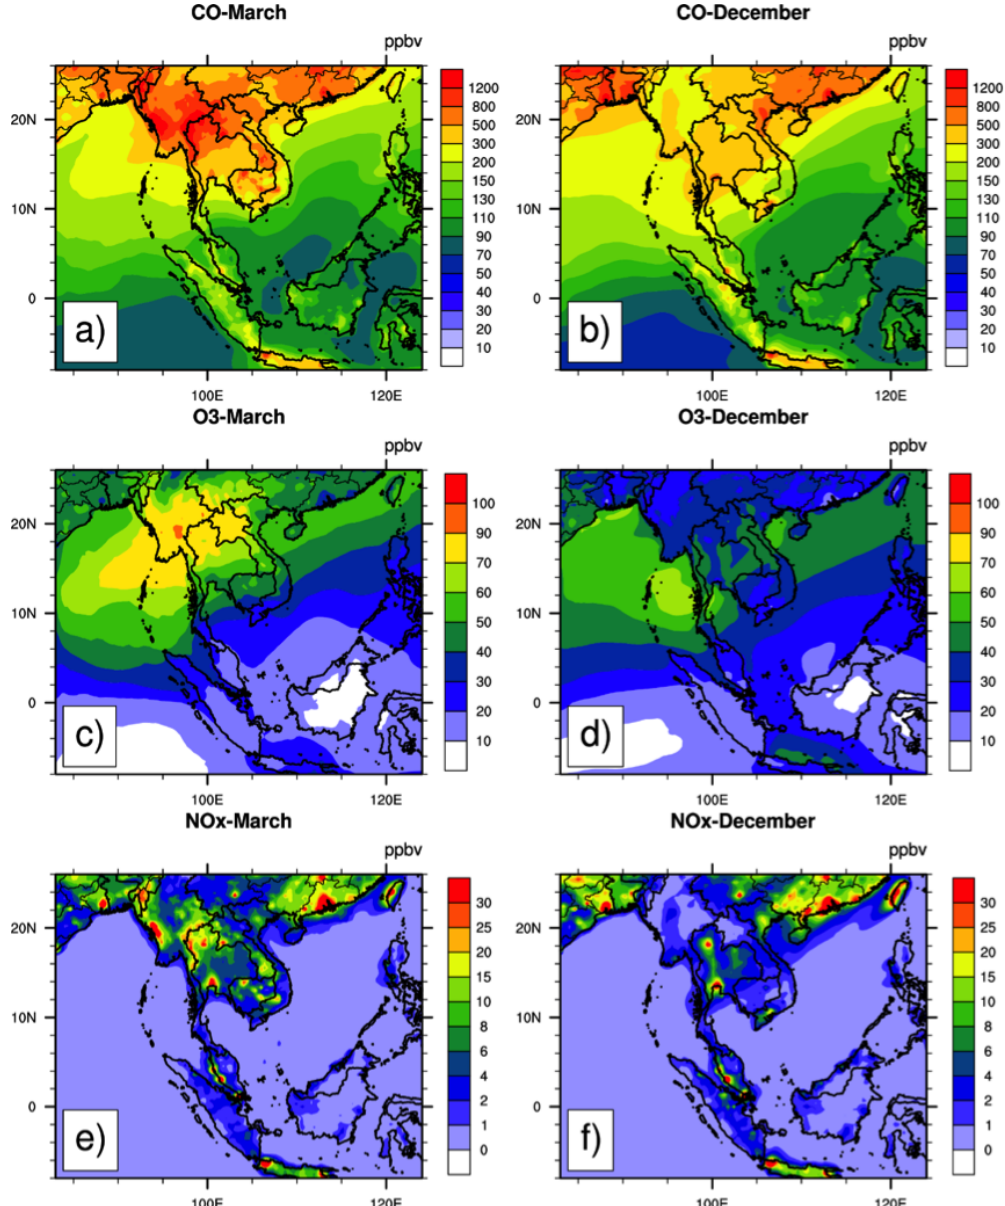
Figure 7. Monthly mean, surface mixing ratios for (a) and (b) CO, (c) and (d) O 3 (e) and (f) NO x predicted by WRF-Chem using the average from five emission inventories for March (left) and December (right panels)